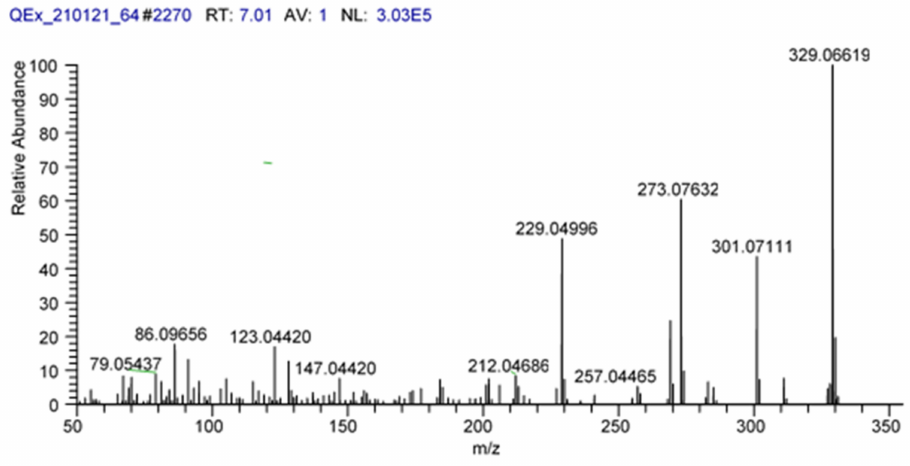
Figure A2. MS/MS spectrum of presumed AfB 1 + O